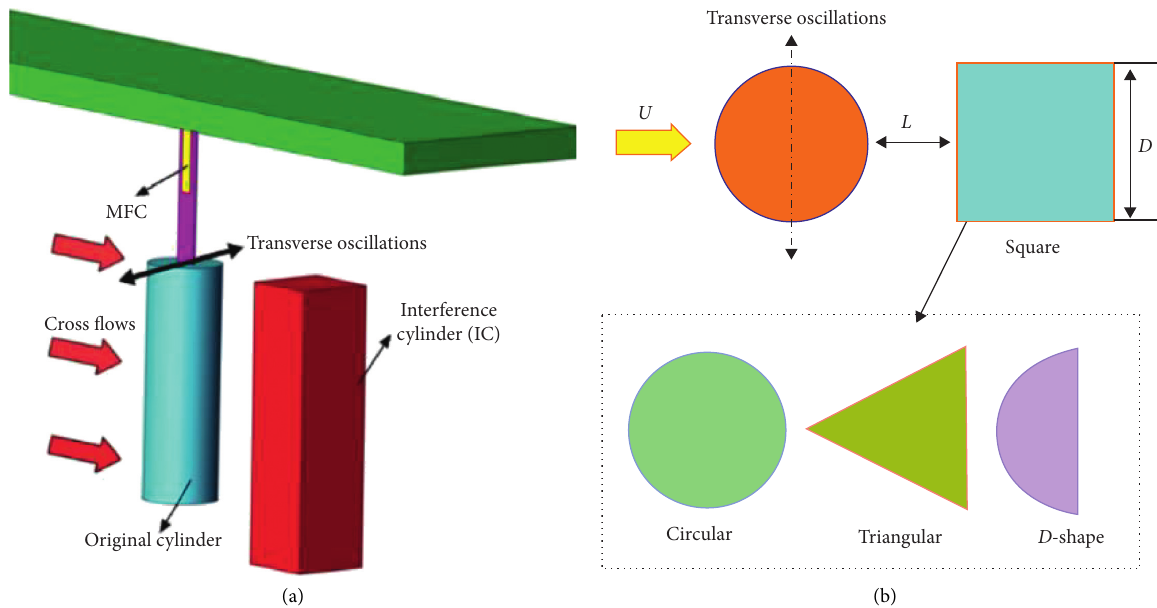
Figure 13: (a) VIV energy harvester. (b) The downstream cylinder in different shapes [117].